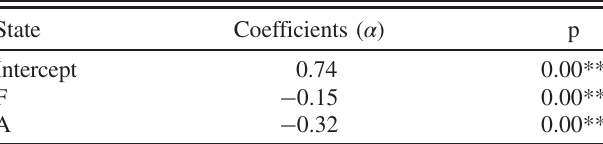
TABLE III. Estimated coefficients and p values for the baseline linear regression model (2).